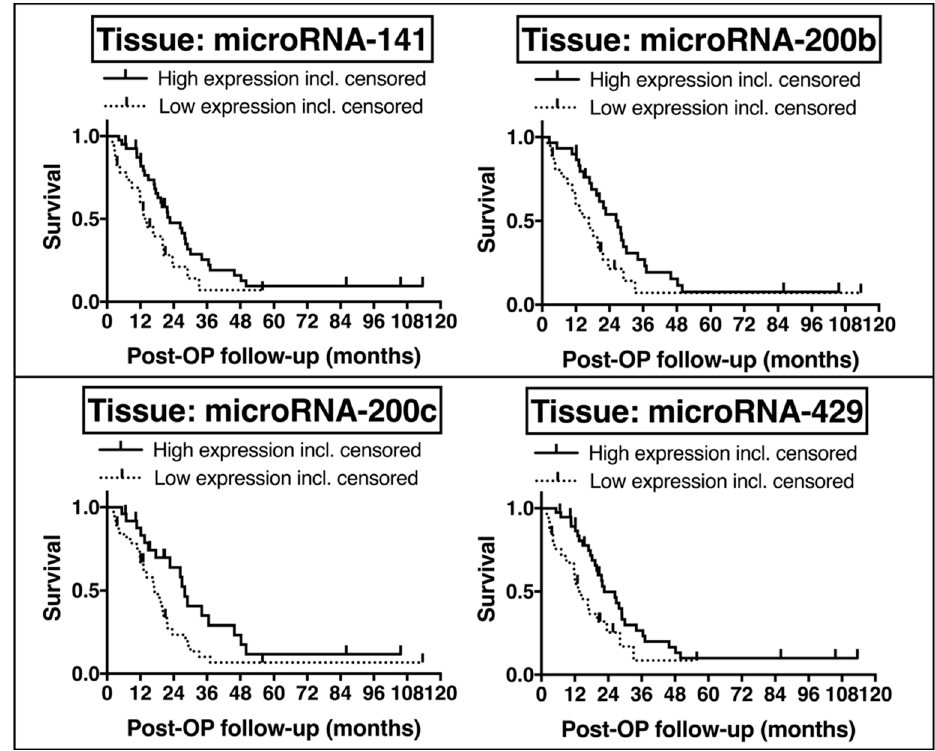
Figure 5. Prognostic impact of EMT-microRNAs by Kaplan-Meier analysis of overall survival in tissue of PDAC UICC Stage II.